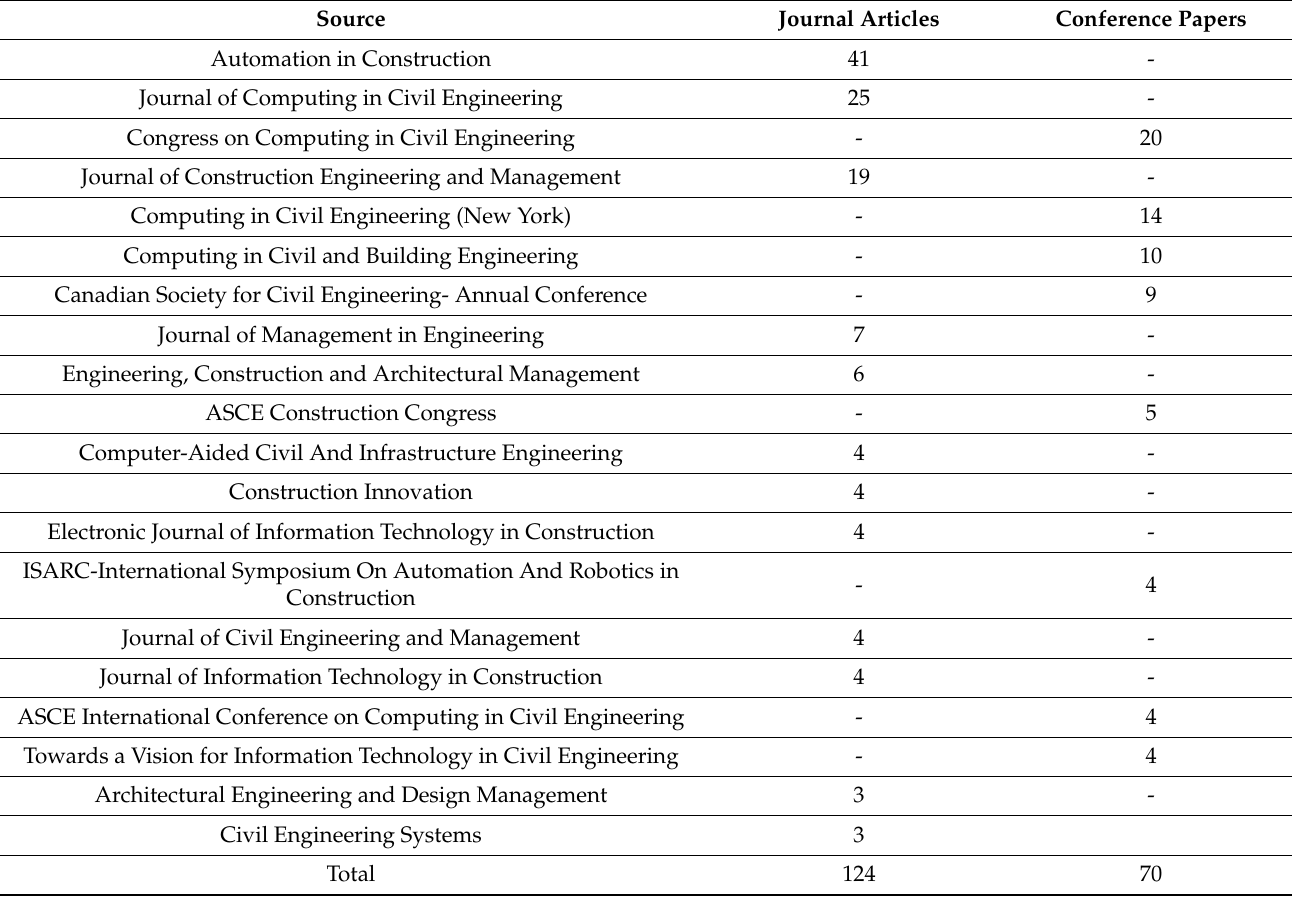
Table 7. First 20 sources ranked by number of